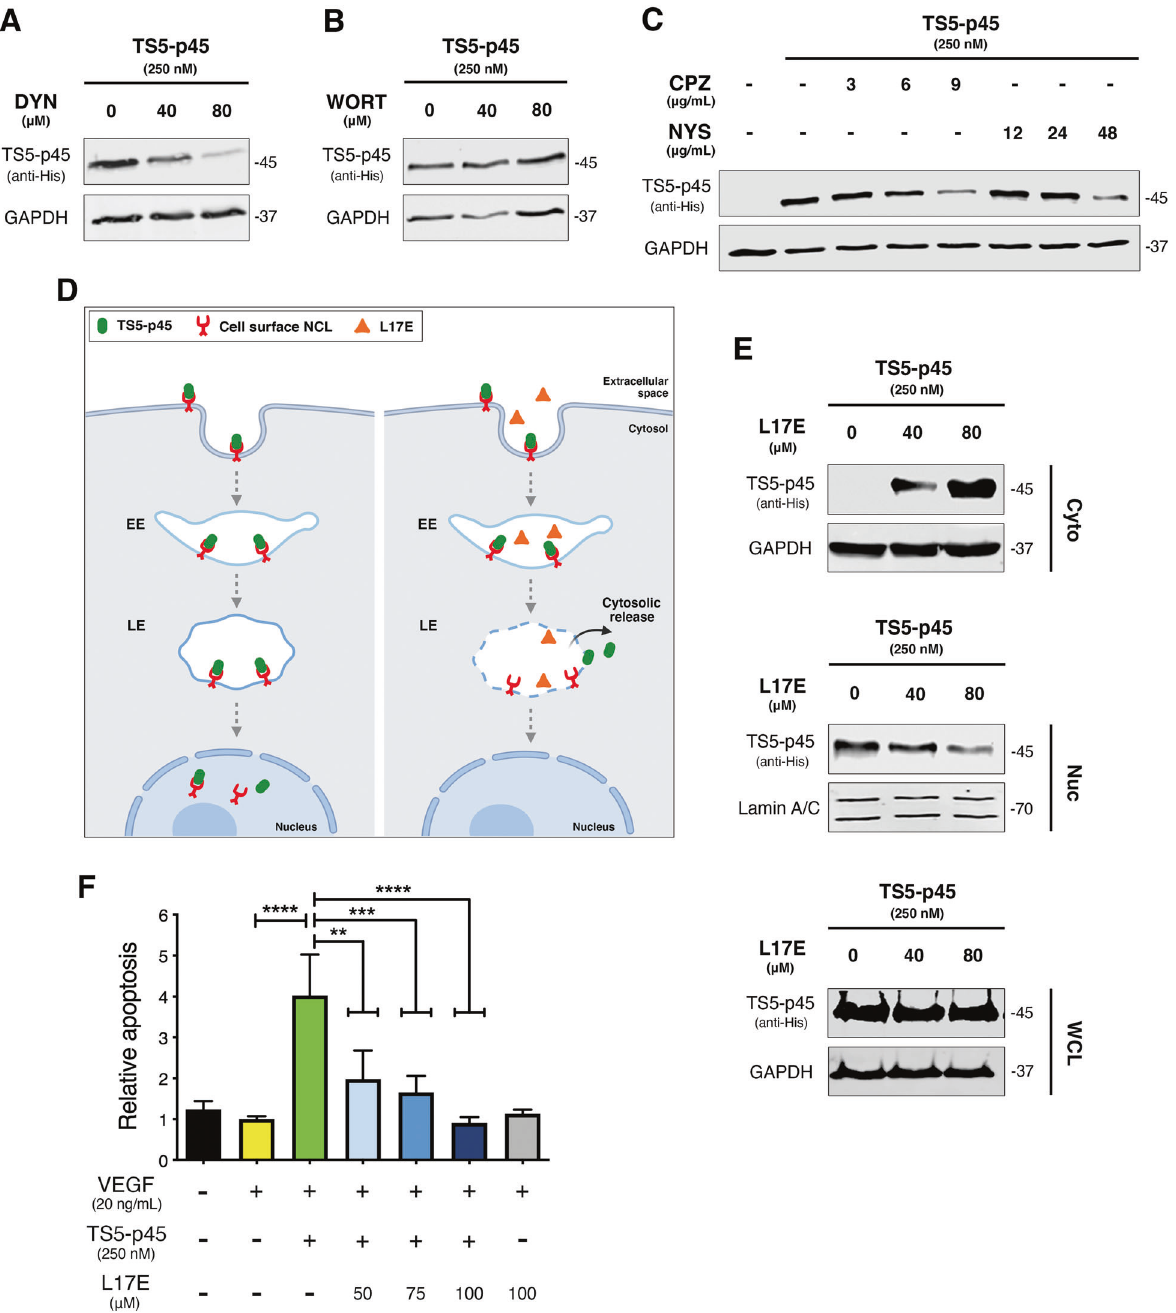
Fig. 5 Intact LEs are required for nuclear traf fi cking and pro-apoptotic activity of TS5-p45. A – C TS5-p45 was internalized into HUVECs through clathrin- and caveolin-dependent endocytosis. HUVECs pre-treated with A DYN, B WORT, and C CPZ and NYS, respectively, before being incubated with TS5-p45. TS5-p45 internalization is shown by anti-His blotting. D A schematic illustration of the action of the endosomolytic L17E peptide, which disrupts the LEs and leads to the release of endosomal cargo into the cytosol. EE, early endosome; LE, late endosome (Created with BioRender.com). E L17E suppresses TS5-p45 translocation to the nucleus. HUVECs were pre-treated with L17E peptide followed by incubation with TS5-p45. TS5-p45 presence in Cyto, Nuc, and WCL fractions was detected by anti-His WB. Loading controls used are GAPDH (Cyto and WCL) and Lamin A/C (Nuc). F L17E quenched the pro-apoptotic activity of TS5-p45. HUVECs pre-treated with L17E peptide before TS5-p45 treatment to induce apoptosis. Apoptosis measurements were done at 24 h post-treatment and normalized to VEGF-containing condition. Data shown are mean ± SD from three independent experiments in triplicates. Statistical analysis was performed by one-way ANOVA. ** p < 0.01, *** p < 0.001, and **** p < in Fig. 5D [32]. As shown in Fig. 5E, L17E peptide dose- to this peptide being endocytosed into cells and traf fi cked to dependently increased TS5-p45 in the cytosol, with a con- LEs. Within the acidic environment of LEs, this peptide perturbs comitant decrease of nuclear-localized TS5-p45 without chan- and lyses the LE membrane, leading to disruption of LE ging the total amount of internalized TS5-p45. These results membrane and release of LE content to the cytosol as depicted